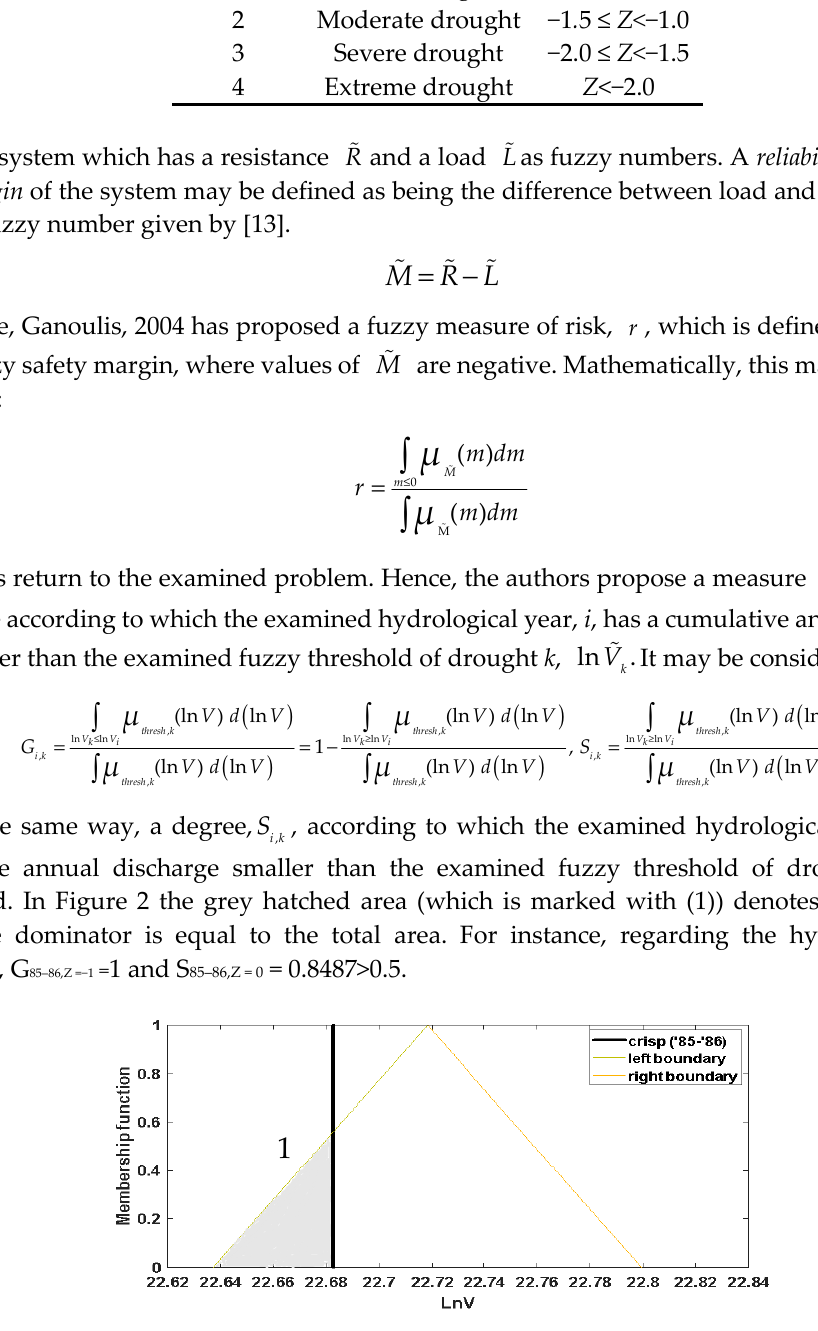
Figure 2. Measure value resulting from the ratio of the hatched area to the total area is less than 0.50 for the year